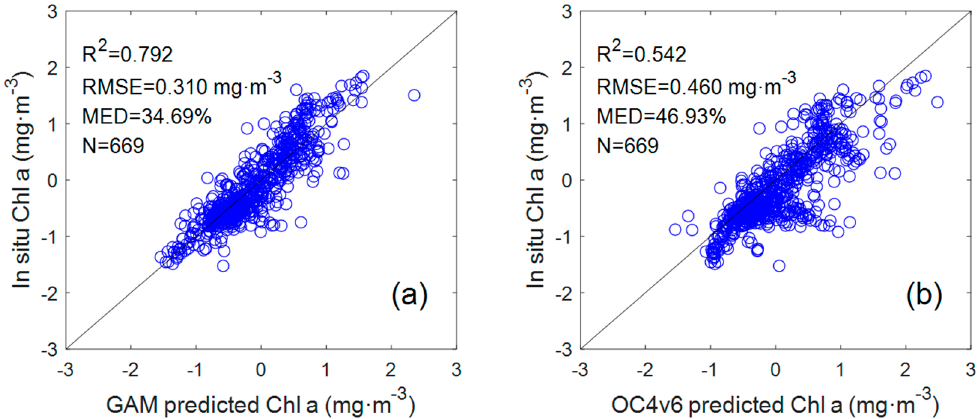
Figure 3. Scatter plots of in situ Chl a versus predicted Chl a: ( a ) GAM; ( b ) OC algorithm. The solid line is the 1:1 line. The N is the number of samples. line is the 1:1 line. The N is the number of samples.